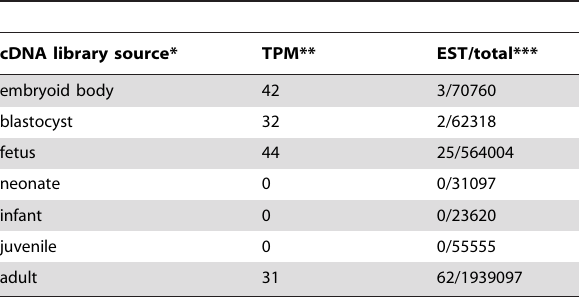
Table 4. EST profiles of DIA1 gene expression during human